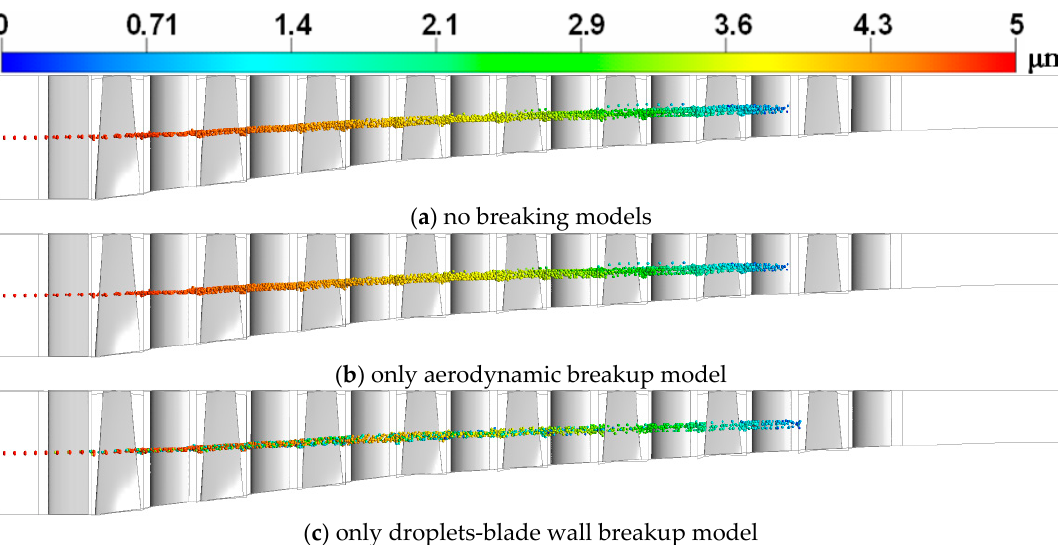
Figure 12. Droplets trajectories of 5 μ m inject from inlet 50% span under 90% rotating speed.